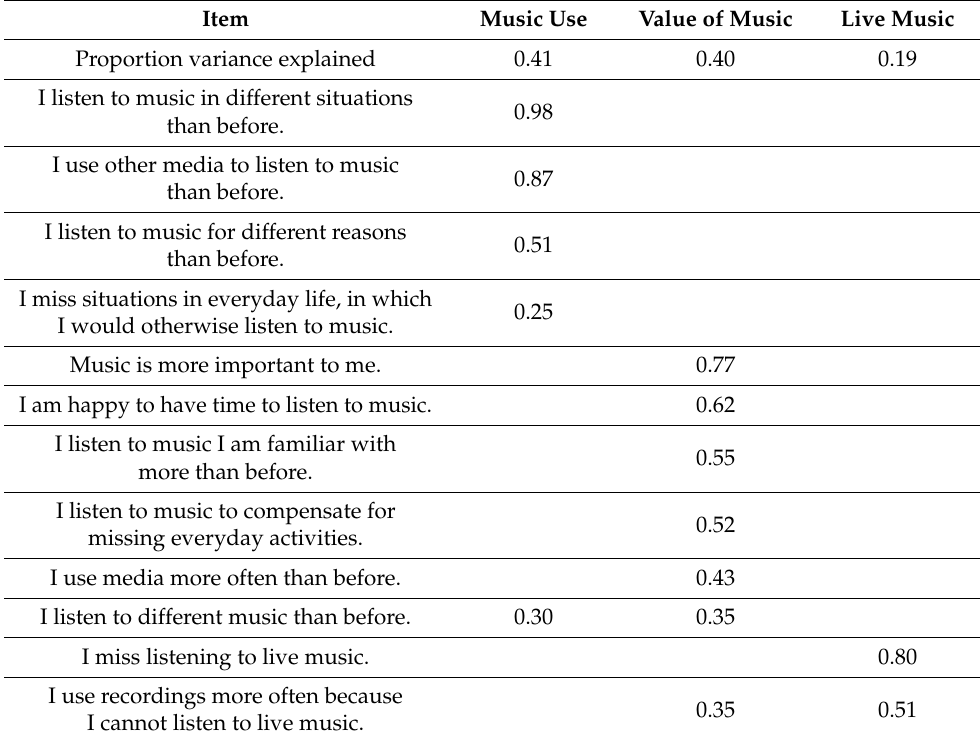
Table 1. Factor solution of the items on perceived changes in music-listening behavior.